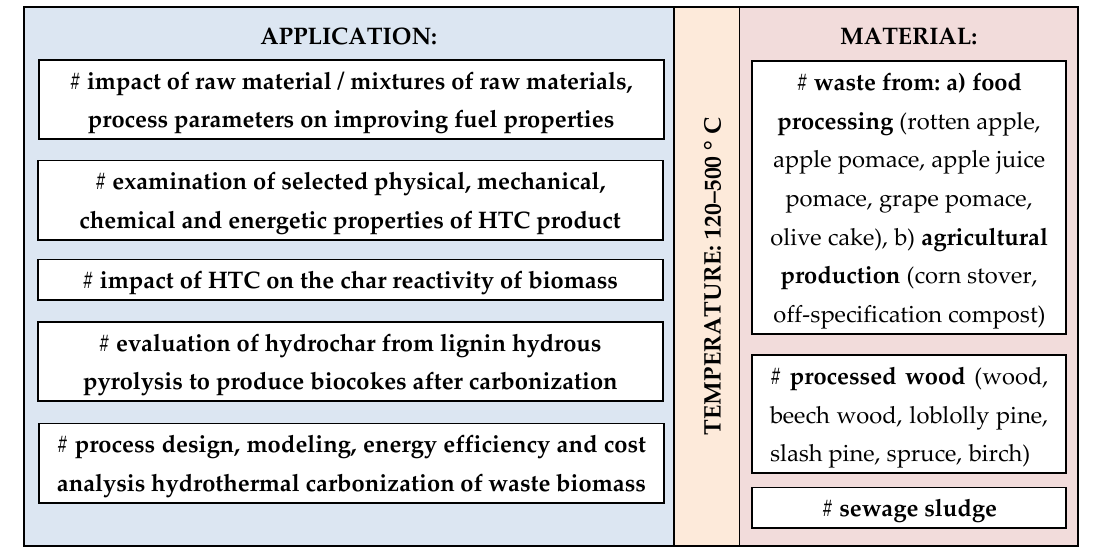
Figure 11. Main research topics and process parameters—the hydrothermal carbonization (HTC). The third group concerned the use of torrefied biomass in the pyrolysis process (Figure 12, Appendix A: Table A3). There are 19 publications in this group.